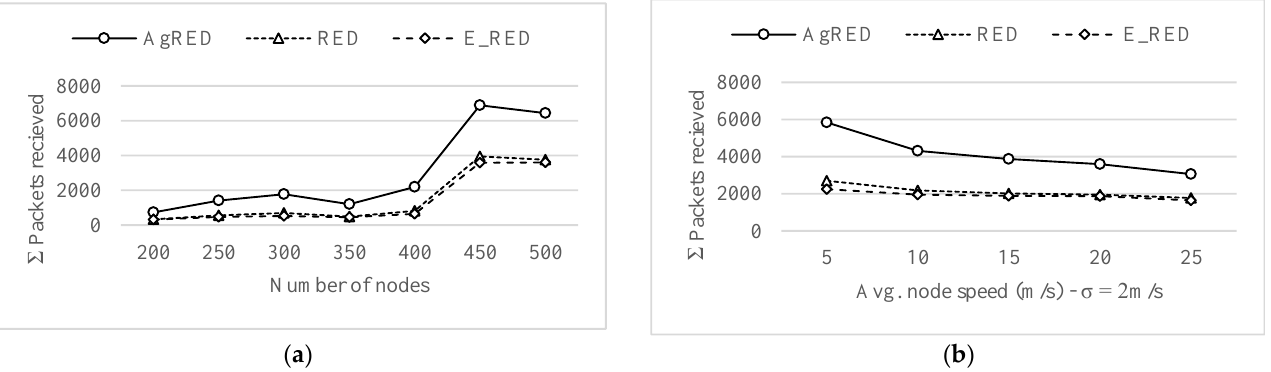
Figure 5. Sum of packets received with UDP traffic for ( a ) varying number of nodes and ( b ) average node speed.